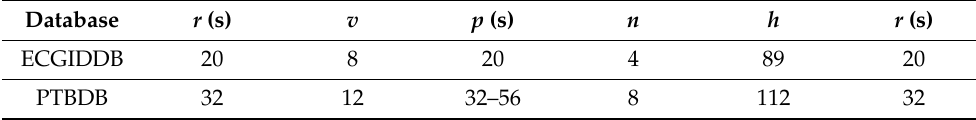
Table 7. Variables used for long time separation